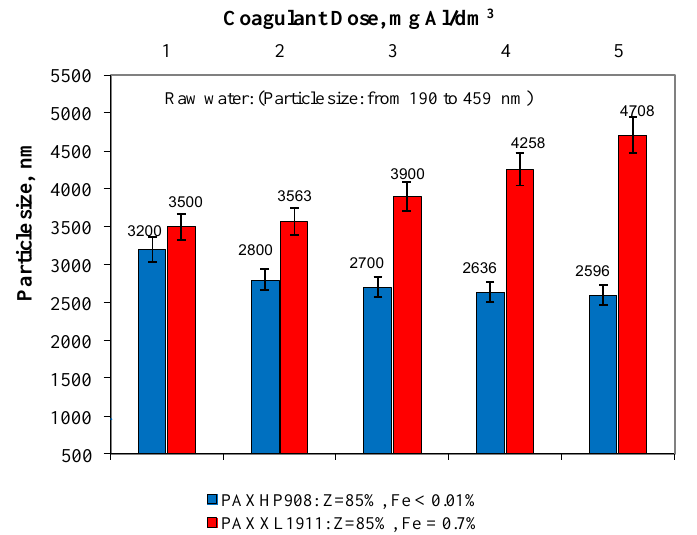
Figure 4. The effect of the type and dose of a coagulant on the change in particle size distribution. Relationship between iron (III), turbidity, colour and organic substances indices, measured as: TOC, DOC and UV 254 showed strong correlations only in water following coagulation with PAXXL1911 containing iron compounds in its composition (Table 1).